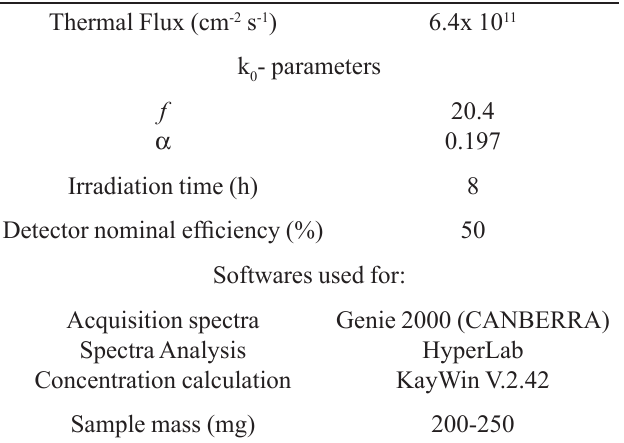
TABLE II - Parameters of neutron activation